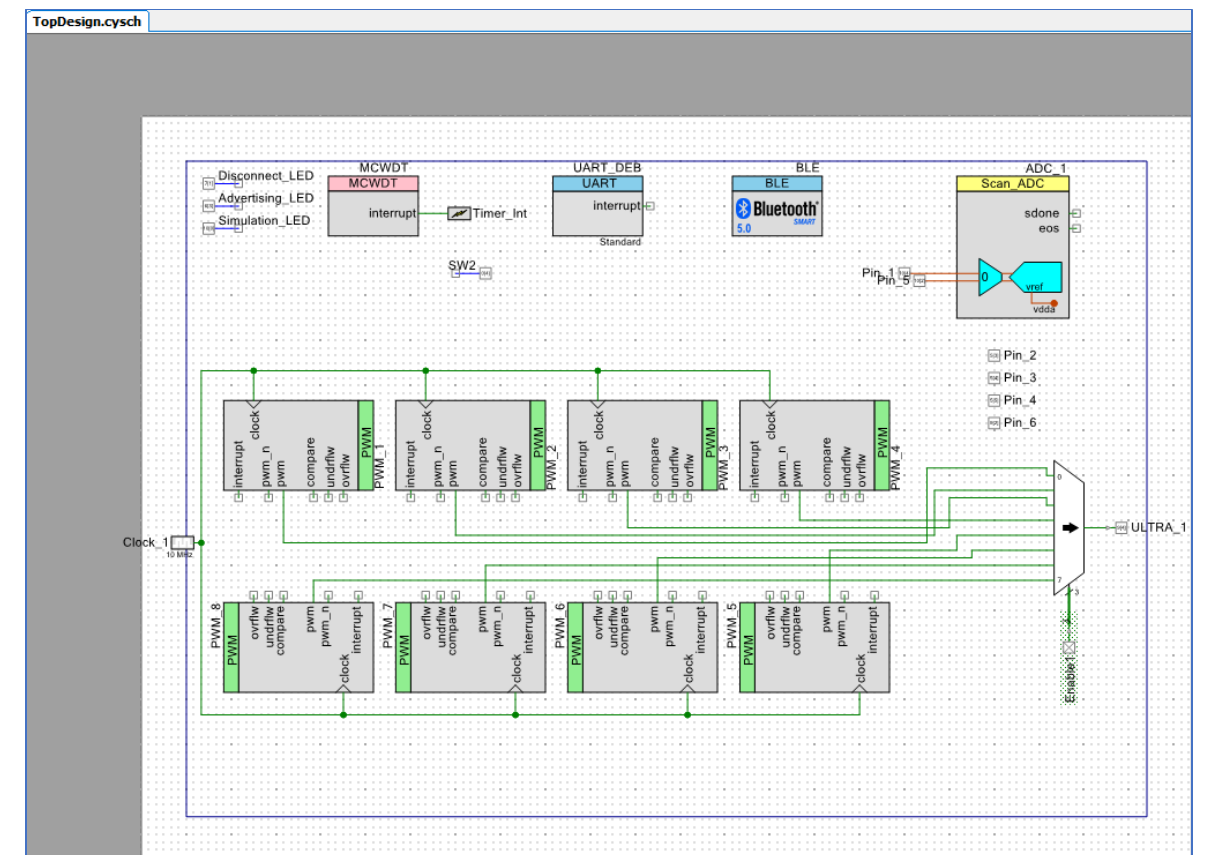
Figure 4. Picture of the experimental setup.